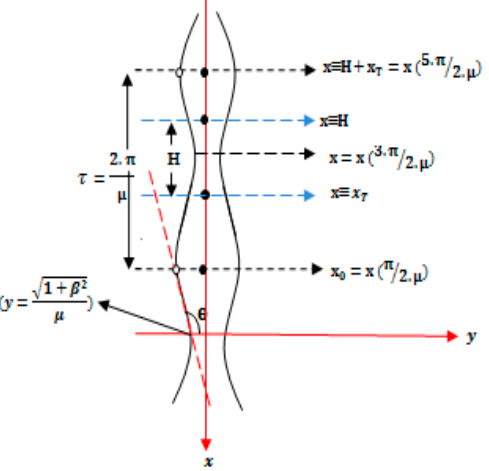
Figure 4. Schematic of liquid bridge profile parameters and coordinates.